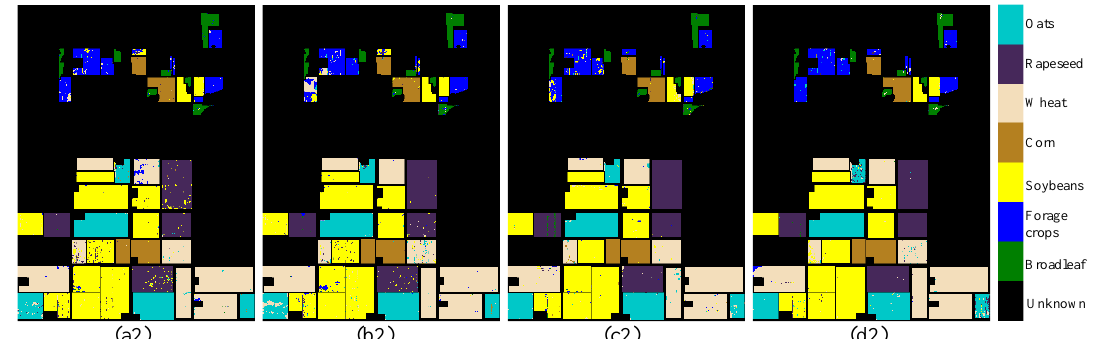
Figure 7 Classification results over the area with seven known land covers. (a1)-(d1) are 17 th June, 22 th June, 3 rd July and 17 th July with the conventional classification scheme, (a2)-(d2) are 17 th June, 22 th June, 3 rd July and 17 th July with the proposed classification